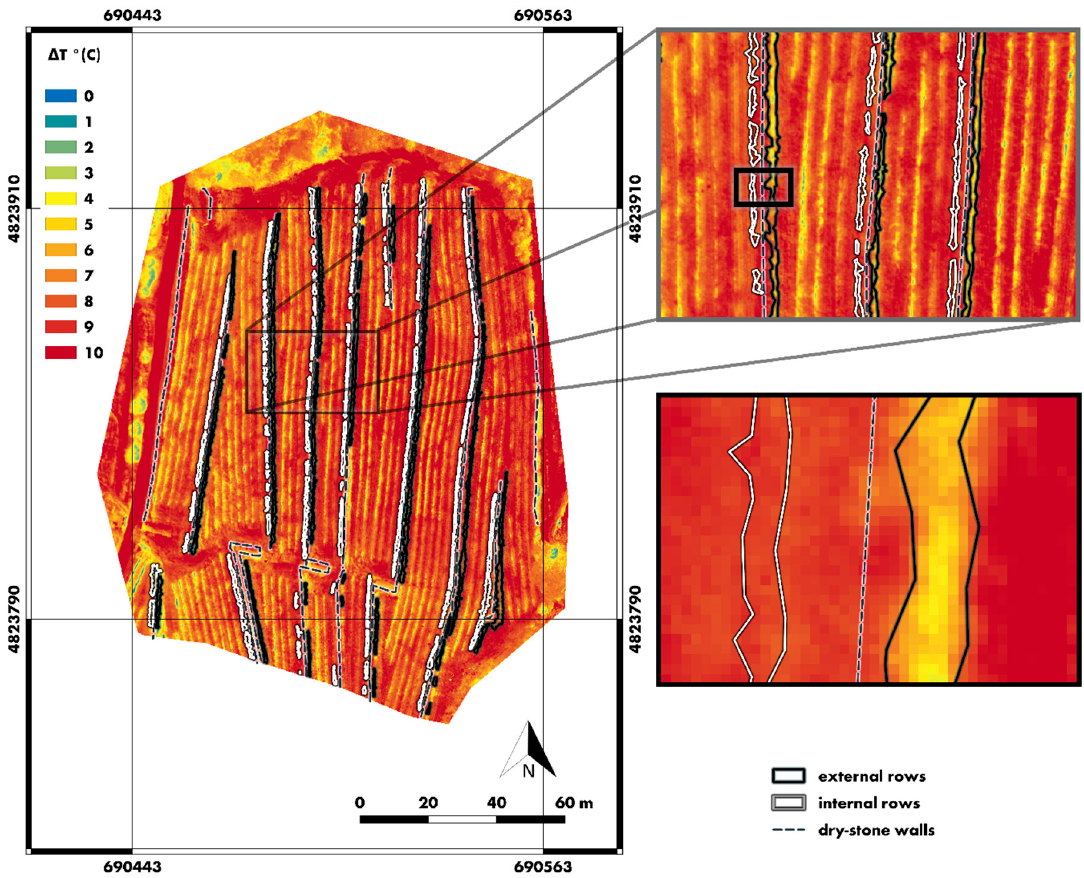
Figure 6. Difference between the afternoon thermal map and the morning orthomosaics highlighting, in the enlarged windows, the behaviour of the internal and external rows.